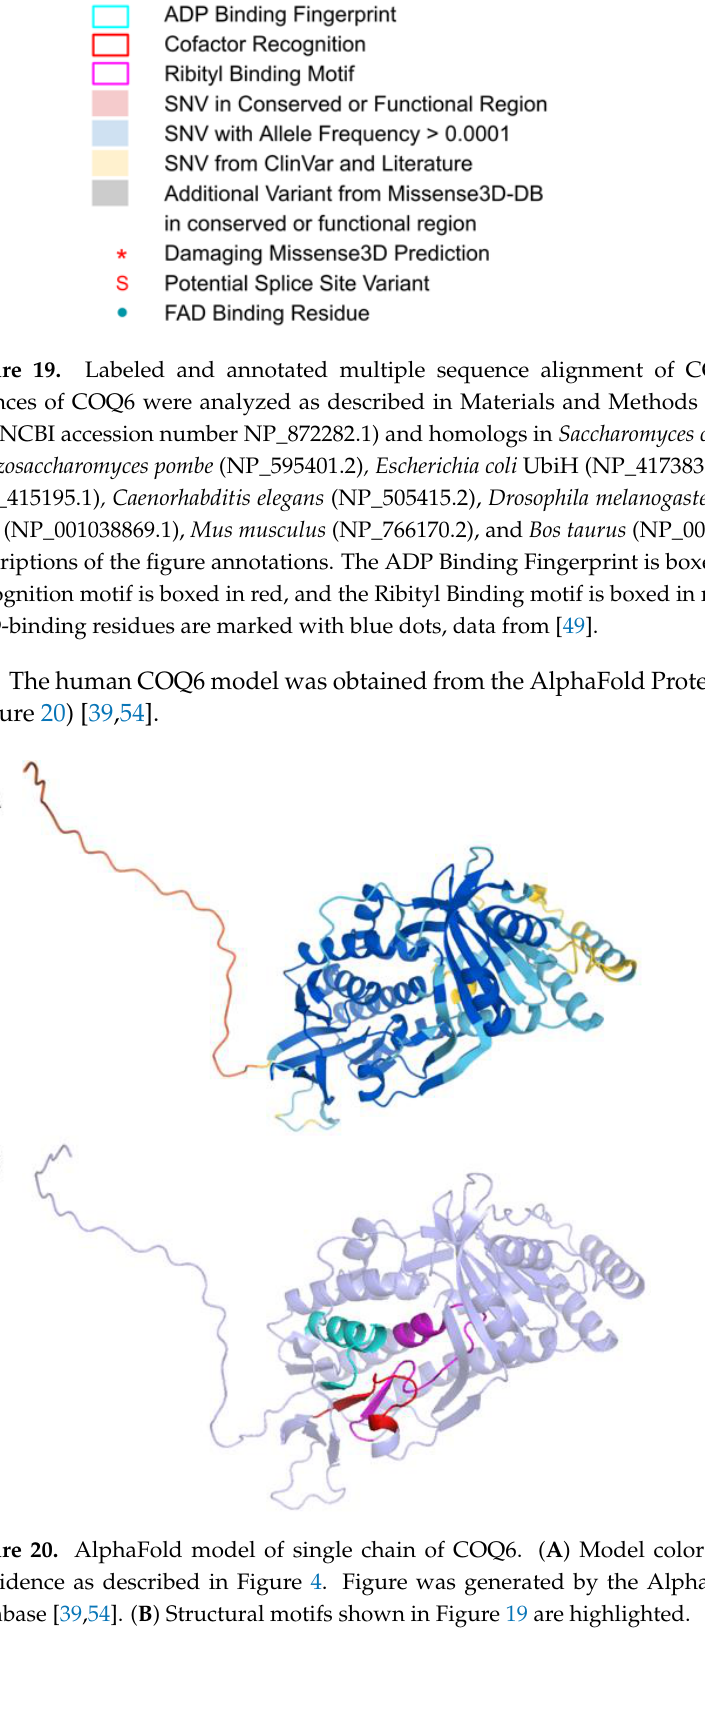
Figure 20. AlphaFold model of single chain of COQ6. ( A ) Model color corresponds to model confi- dence as described in Figure 4. Figure was generated by the AlphaFold Protein Structure Database [39,54]. ( B ) Structural motifs shown in Figure 19 are highlighted.